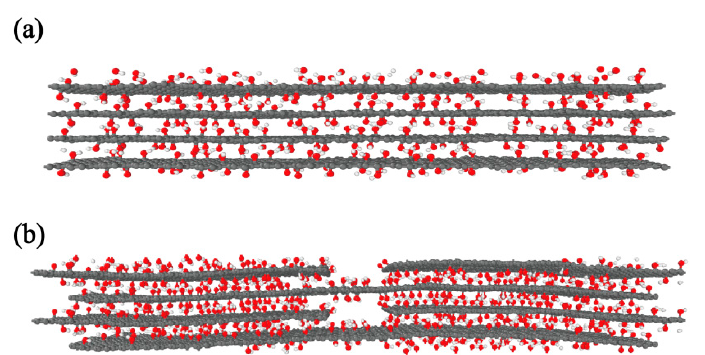
Figure 1. Two stack types of GO films ( a ) a layer-by-layer model ( b ) an overlap model.